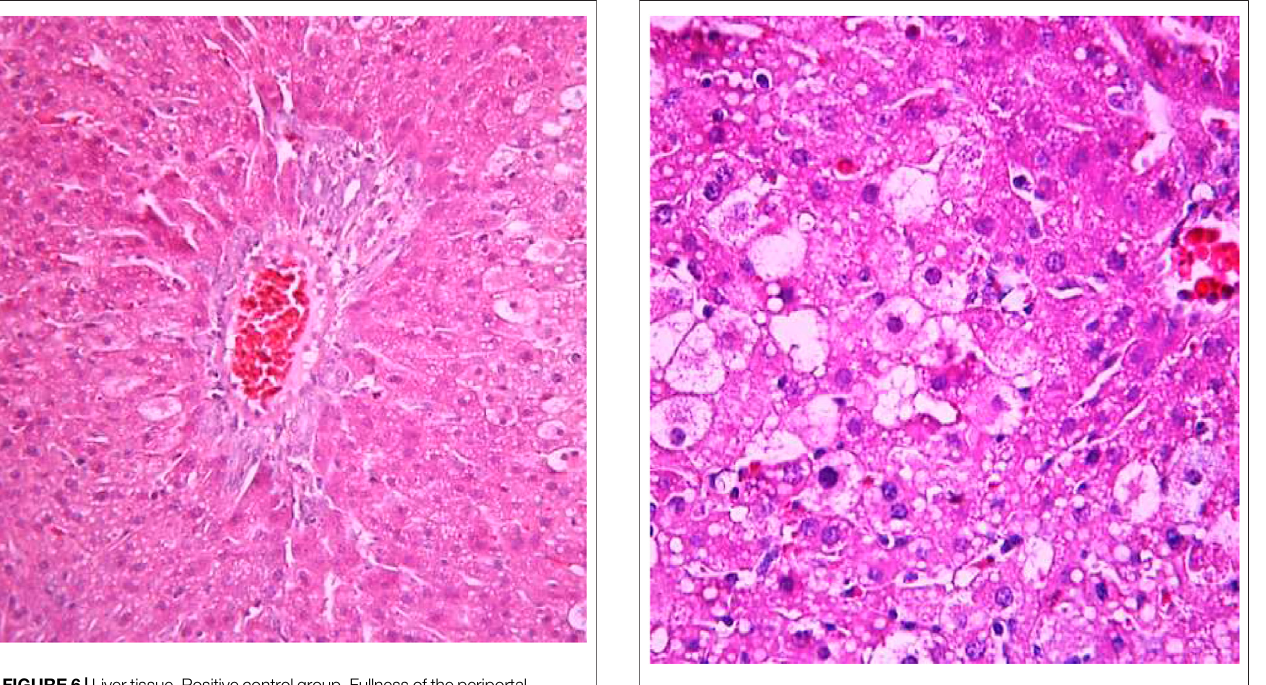
FIGURE 8 | Liver tissue. Positive control group. Visible groups of hepatocytes in the state of intralobular focal necrosis, the cytoplasm contains light mesh-like formations. Stain: hemotoxin and eosin. Magni fi cation × 400.